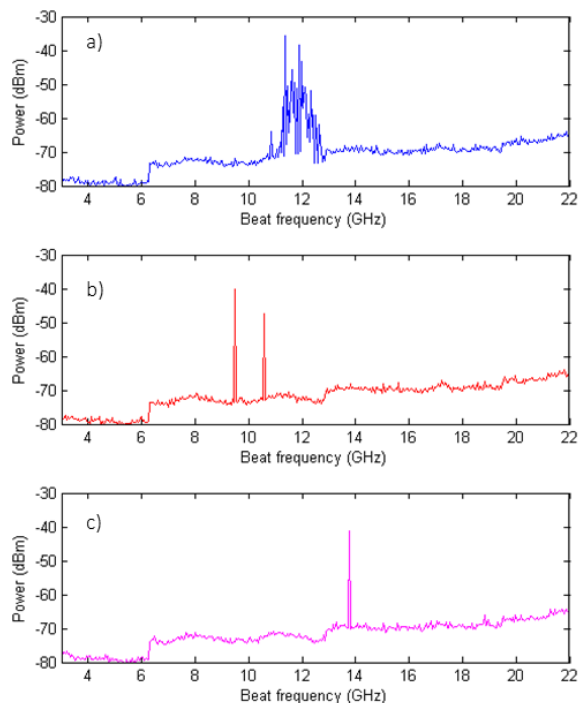
Figure 5. Electric beat with a tunable laser source (TLS) of the laser output for each tested